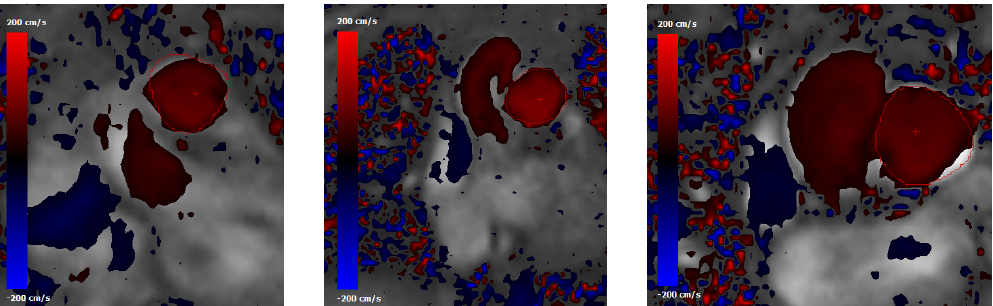
Figure 6. Phase-contrast MRI data showing normal-to-plane velocity maps at the main pulmonary artery (MPA) cross section for (from left to right) subjects #1, #2 and #5. The MPA contour is highlighted with a red line. The red cross indicates the point where the peak velocity